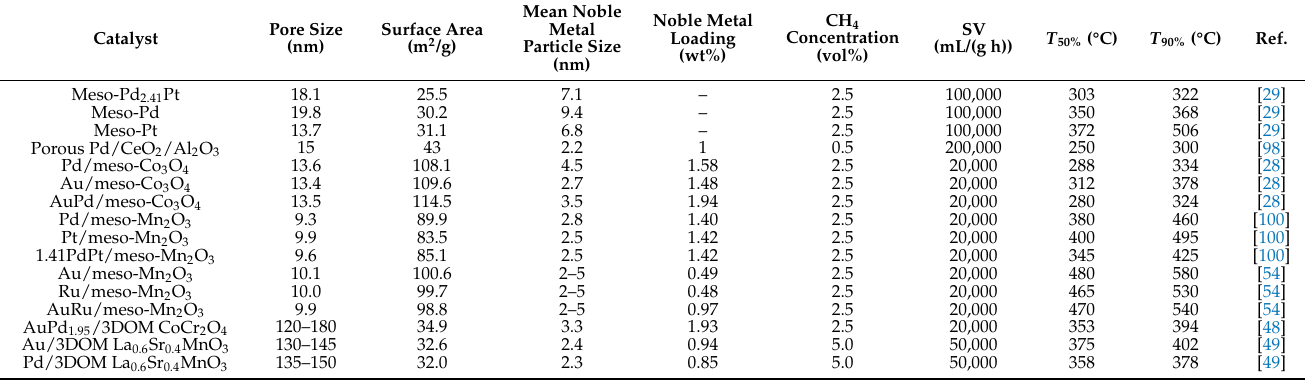
Table 3. Catalytic performance for CH 4 combustion over the ordered porous composite oxide and supported noble metal